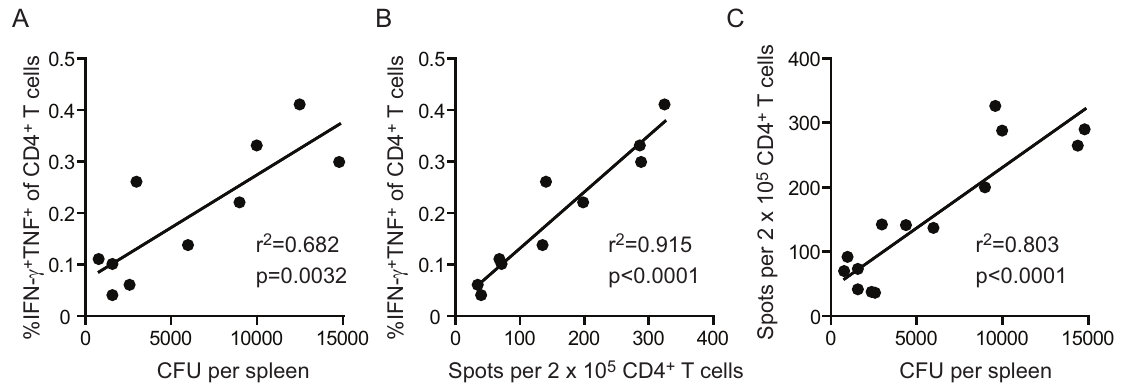
Figure 6. Polyfunctional CD4 + T cell responses correlate with disease activity of virulent Salmonella . C57BL/6 mice were infected orally with 1 6 10 7 virulent Salmonella Typhimurium and at day 14 and 21 post-infection the bacterial burden and Salmonella -specific CD4 + T cell responses were analyzed. (A) Correlation between the frequency of STM1540 262–276 -specific IFN- c + TNF + CD3 + CD4 + T cells and the recoverable Salmonella CFU in the spleen. (B) Correlation between the number of IFN- c spots (as determined by ELISPOT) and the frequency of STM1540 262–276 -specific IFN- c + TNF + CD3 + CD4 + T cells. (C) Correlation between the STM1540 262–276 -specific IFN- c ELISPOTS and recoverable Salmonella CFU in the spleen. Data are cumulative from 12–15 Salmonella -infected mice analyzed at day 14 and 21 post-infection. Two independent experiments were performed at each timepoint post-infection with 3–5 mice per experiment. Correlation coefficient and significance value is indicated. Each data point represents an individual mouse.